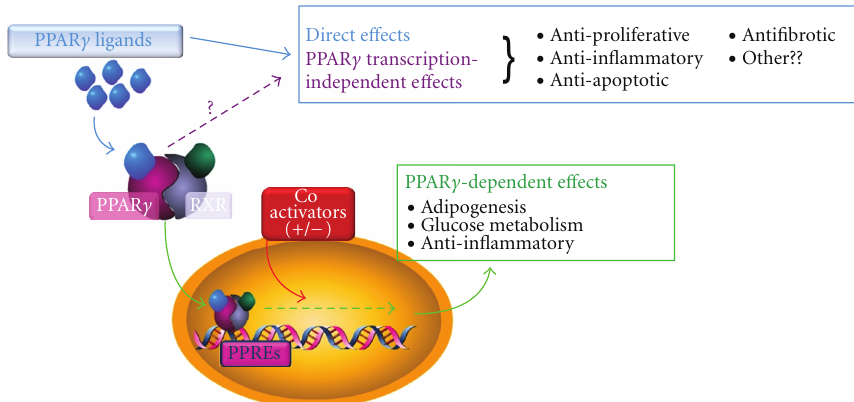
Figure 1: PPAR γ ligands have multiple PPAR γ -independent e ff ects. In the classical PPAR γ -dependent pathway, ligand-bound PPAR γ forms a heterodimer with RXR and binds to PPAR γ -response elements (PPREs) which leads to modulation of transcription. However, PPAR γ ligands also exhibit direct e ff ects that do not involve transcriptional activation by PPAR γ /RXR. These direct e ff ects may involve PPAR γ protein interacting with PPAR γ ligands in a “non-classical manner” (not involving RXR or PPRE) or may be completely independent of PPAR γ (functioning even in the complete absence of PPAR γ protein, i.e., direct e ff ects). PPAR γ -independent e ff ects can alter multiple cellular programs including regulation of di ff erentiation, inflammation, apoptosis and may be of significant therapeutic